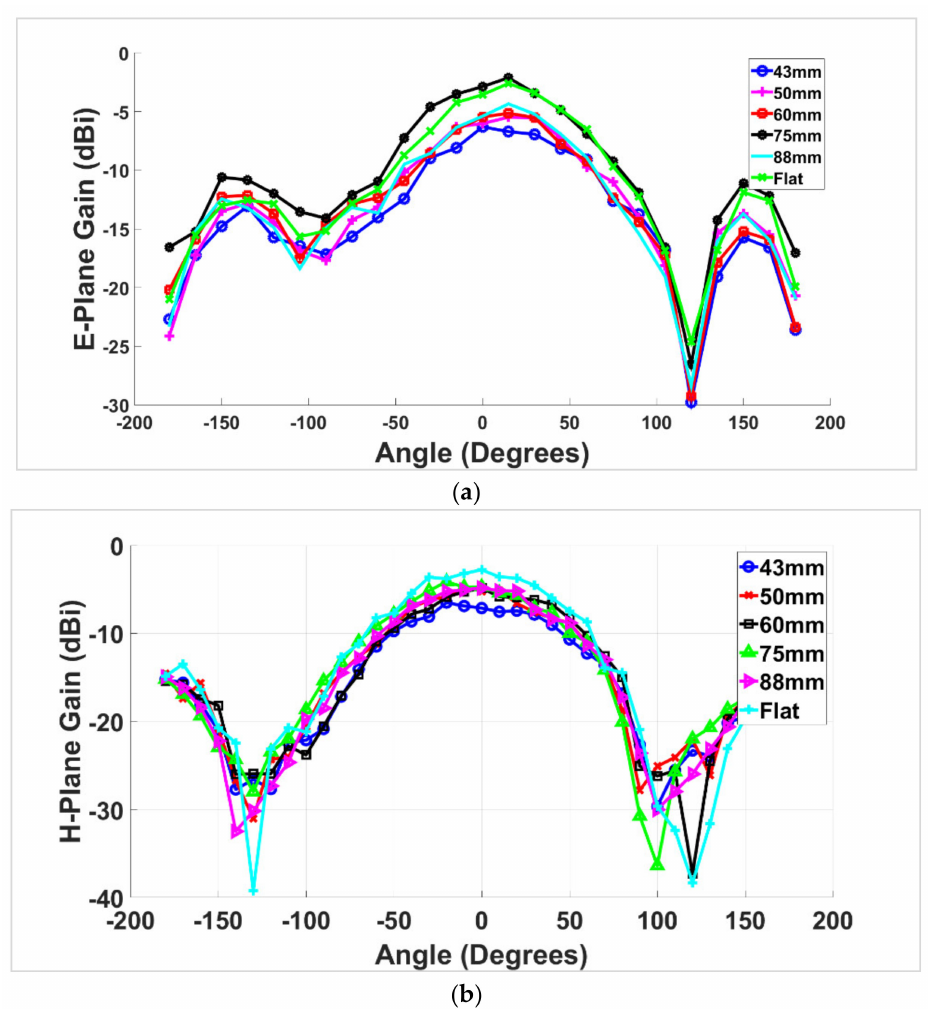
Figure 13. Comparisons of the measured gain of the 3D-printed Electrifi antenna in principal E- and H-planes at 2.4 GHz under different bending conditions: ( a ) E-plane gain; ( b ) H-plane